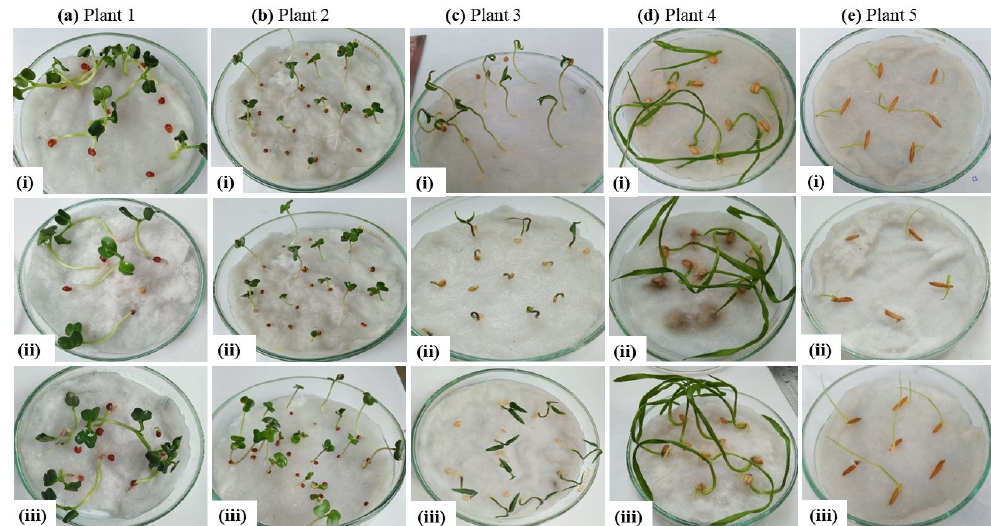
Figure 4. ( a ) Plant 1: R. sativus (Radish) seedlings grown in 100% concentration of ( i ) control (distilled water), ( ii ) untreated and ( iii ) treated hospital wastewater after two weeks; ( b ) Plant 2: B. oleracea L. (Cauliflower) seedlings grown in 100% concentration of ( i ) control (distilled water), ( ii ) untreated and ( iii ) treated hospital wastewater after two weeks; ( c ) Plant 3: C. annuum L. (Hot pepper) seedlings grown in 100% concentration ( i ) control (distilled water), ( ii ) untreated and ( iii ) treated hospital wastewater after two weeks; ( d ) Plant 4: T. aestivum L. (Wheat) seedlings grown in 100% concentration ( i ) control (distilled water), ( ii ) untreated and ( iii ) treated hospital wastewater after two weeks; ( e ) Plant 5: O. sativa L. (Rice) seedlings grown in 100% concentration ( i ) control (distilled water), ( ii ) untreated and ( iii ) treated hospital wastewater after two weeks.